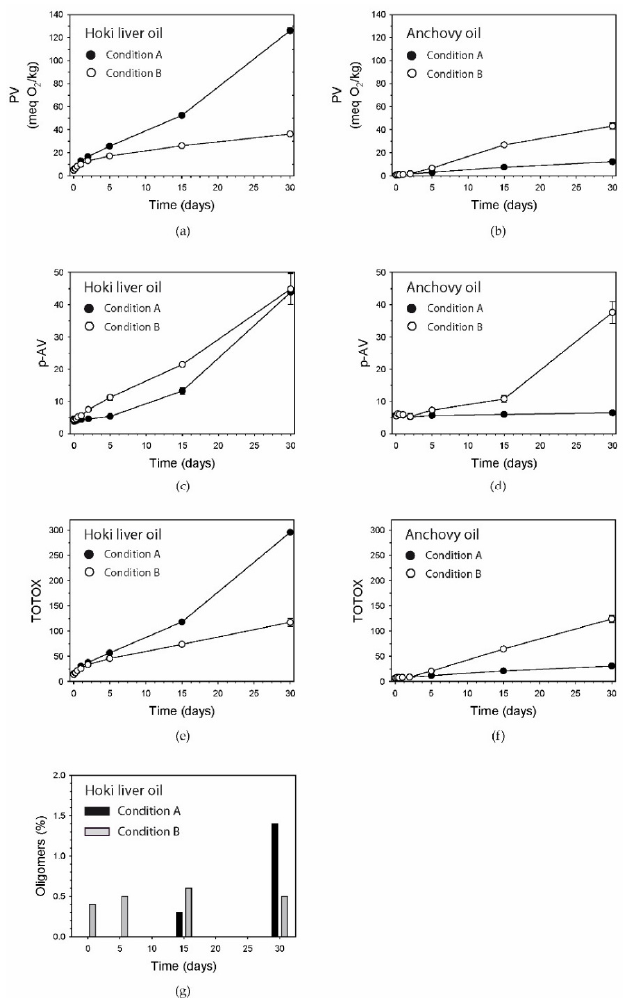
Figure 1. Oxidative changes over a 30-day period of exposure under Conditions A (black circles) and B (open circles): ( a ) peroxide value (PV) of hoki liver oil and ( b ) anchovy oil, ( c ) para -anisidine value (p-AV) of hoki liver oil and ( d ) anchovy oil, and ( e ) total oxidation number (TOTOX) number of hoki